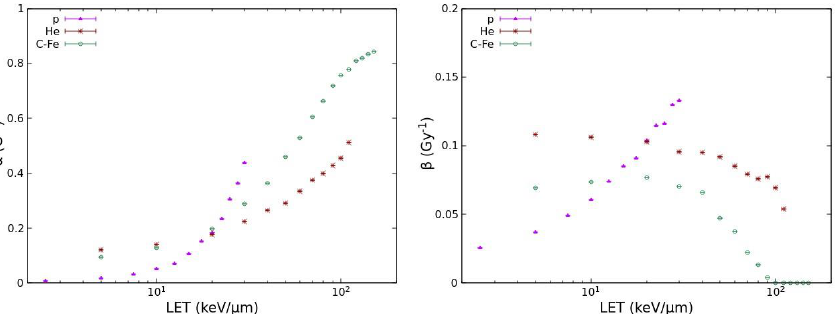
Fig. 2. Values of the coefficients ɑ (left panel) and β (right panel) for lymphocyte dicentrics as a function of LET for the different ion beams considered in this